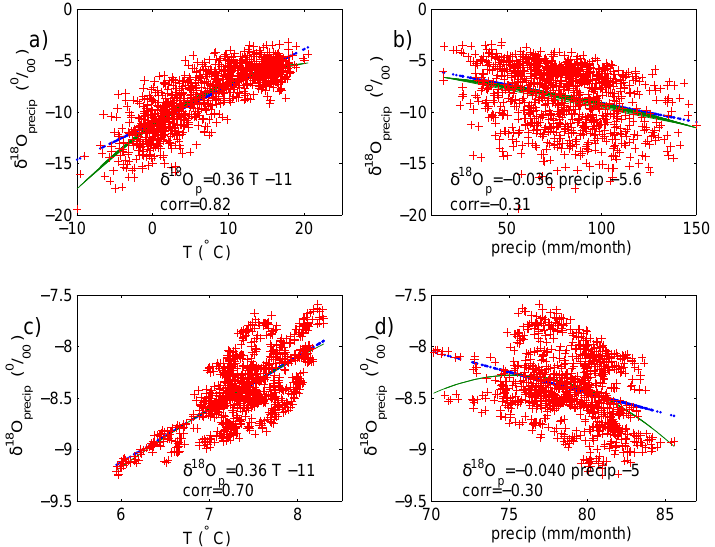
Fig. 2. Relationships between local δ 18 O precip vs. surface temperature (a, c) and precipitation (b, d) at the cave site. (a) and (b) for the monthly values, and (c) and (d) for the 60-month running mean values. The linear regression lines are shown in blue; green lines indicate a second-order polynomial fit.